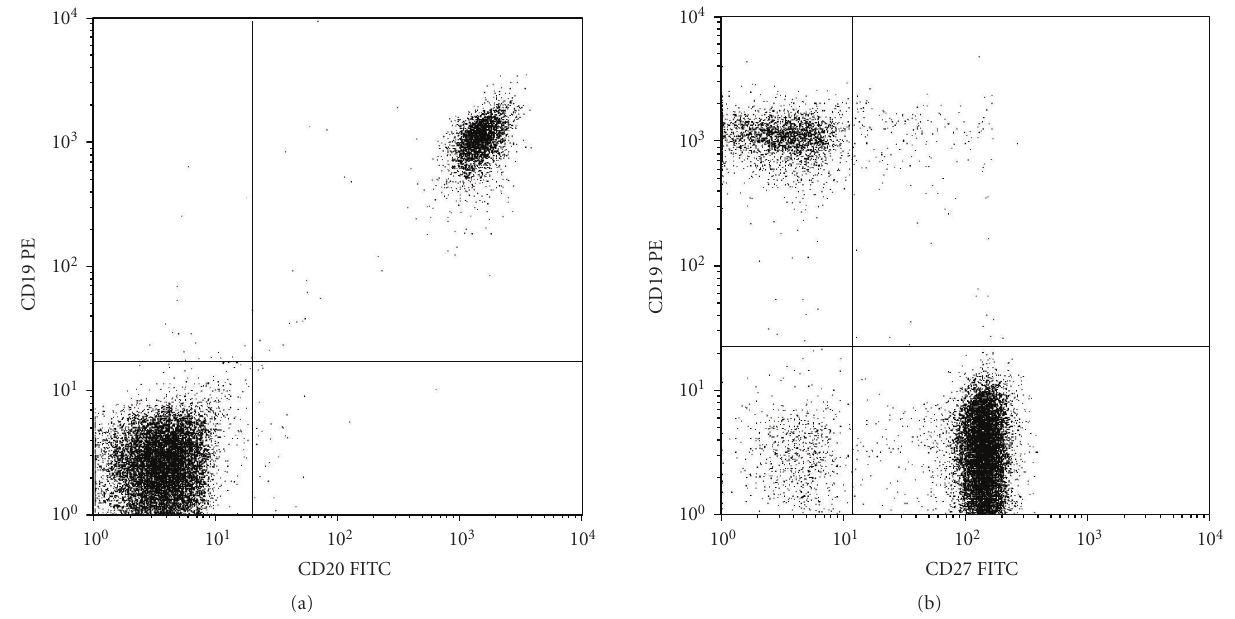
Figure 1: Flow cytometric analysis of peripheral blood lymphocytes, taken from the neonate at the age of six months, indicating the presence of CD19 positive B-lymphocytes (20% on average; (a) and (b)), expressing the maturation marker CD20 (99%; (a), and partly expressing the memory marker CD27 (7%; (b). Analysis was done within the CD45 positive total lymphocyte